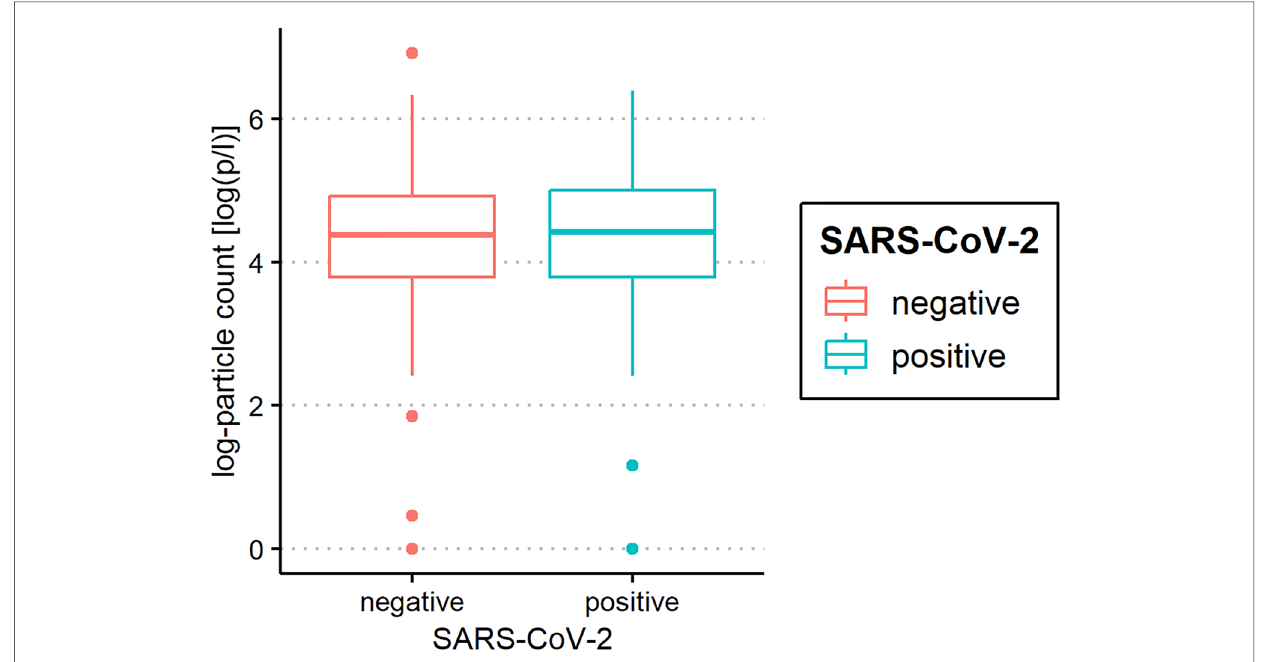
FIGURE 3 Aerosol measurement of severe acute respiratory syndrome coronavirus 2 (SARS-CoV-2) polymerase chain reaction (PCR) -positive and PCR-negative children and adolescents. Exhaled particle counts (in particles/liter, displayed on a logarithmic scale, y -axis) in SARS-CoV-2- PCR-positive and PCR- negative children and adolescents ( x -axis).